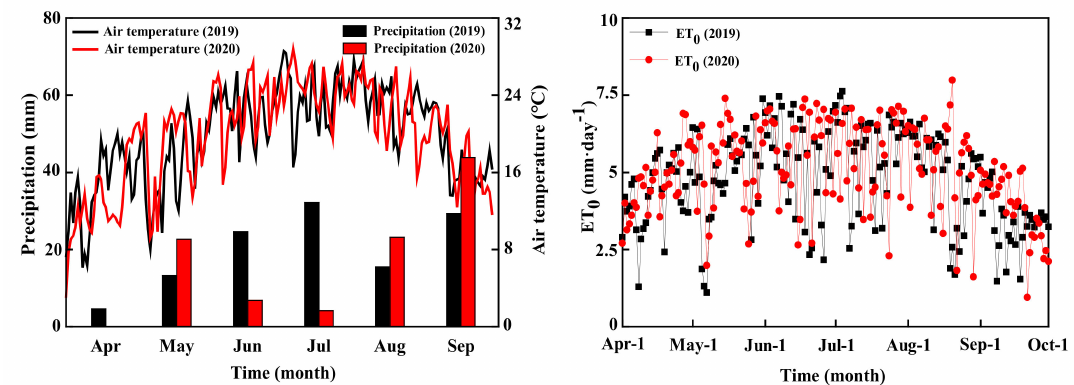
Figure 2. Monthly precipitation amounts and daily air temperature ( Left ), and evapotranspiration (ET 0 ) ( Right ) in the experimental area during a maize growth